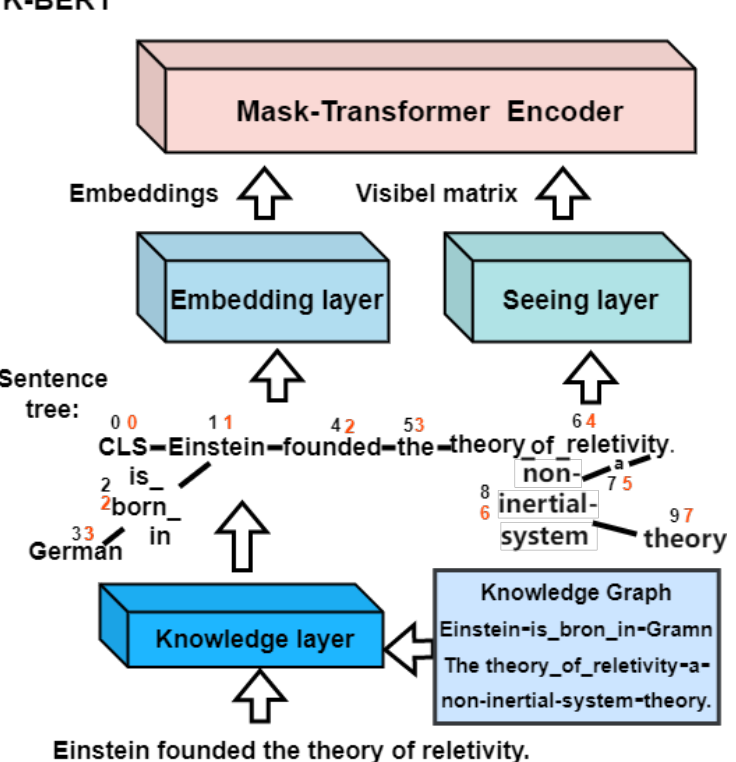
Figure 6. An illustration of K-BERT structure and the processing of a sentence sample. Black numbers represent hard position indices. Red numbers represent soft position